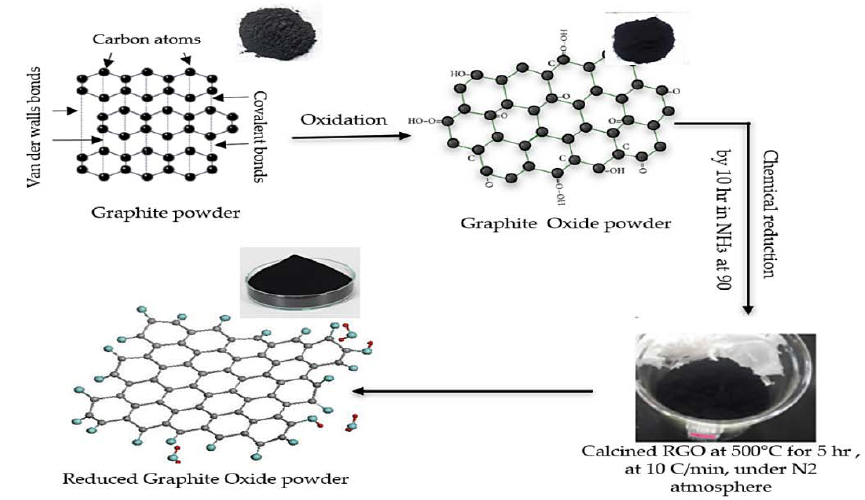
Figure 2. Schematic drawings for the preparation of reduced graphene oxide powder.